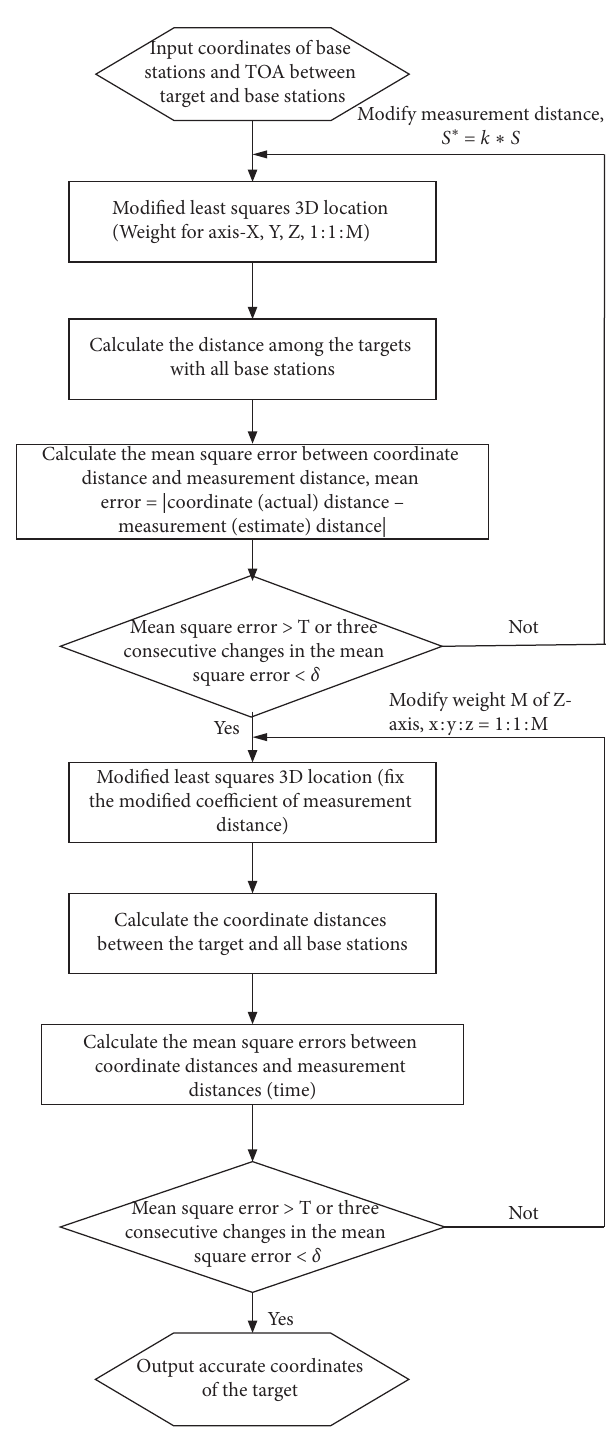
Figure 3: The flow chart of the modified least squares